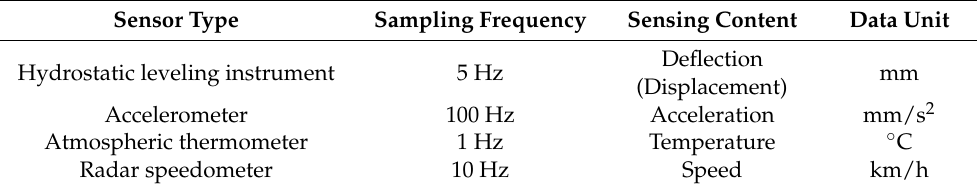
Figure 2. Sensor location of each monitoring section (unit: millimeters). Table 1. Sensing details for multiple types of sensors.